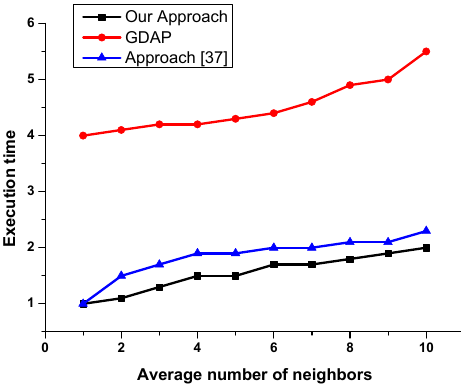
Figure 7. Comparison between the three approaches based on execution time.